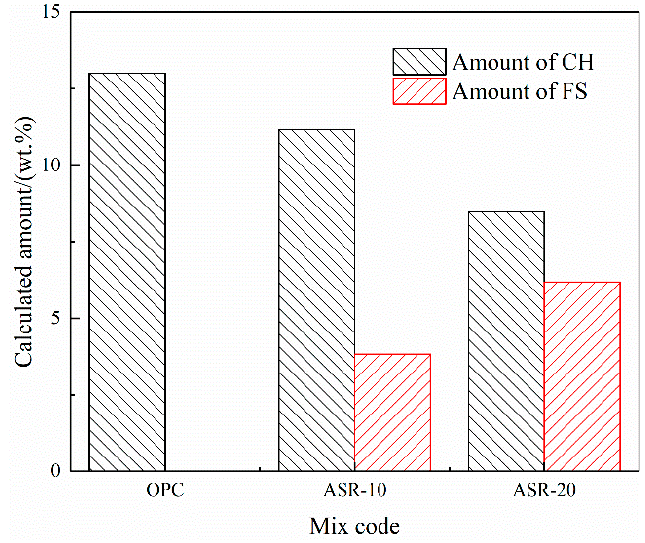
Figure 5. Calculated amounts of Ca(OH) 2 and Friedel’s salt in the ASR-cement hardened